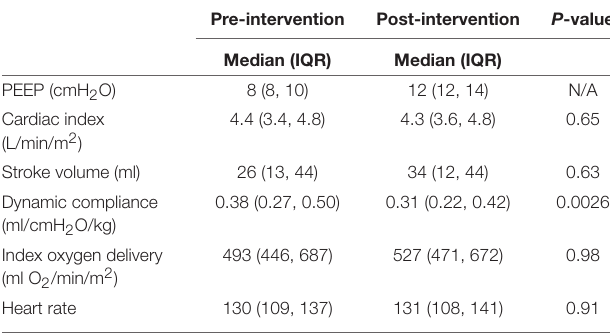
TABLE 2 | Changes in outcome measurements associated with increased